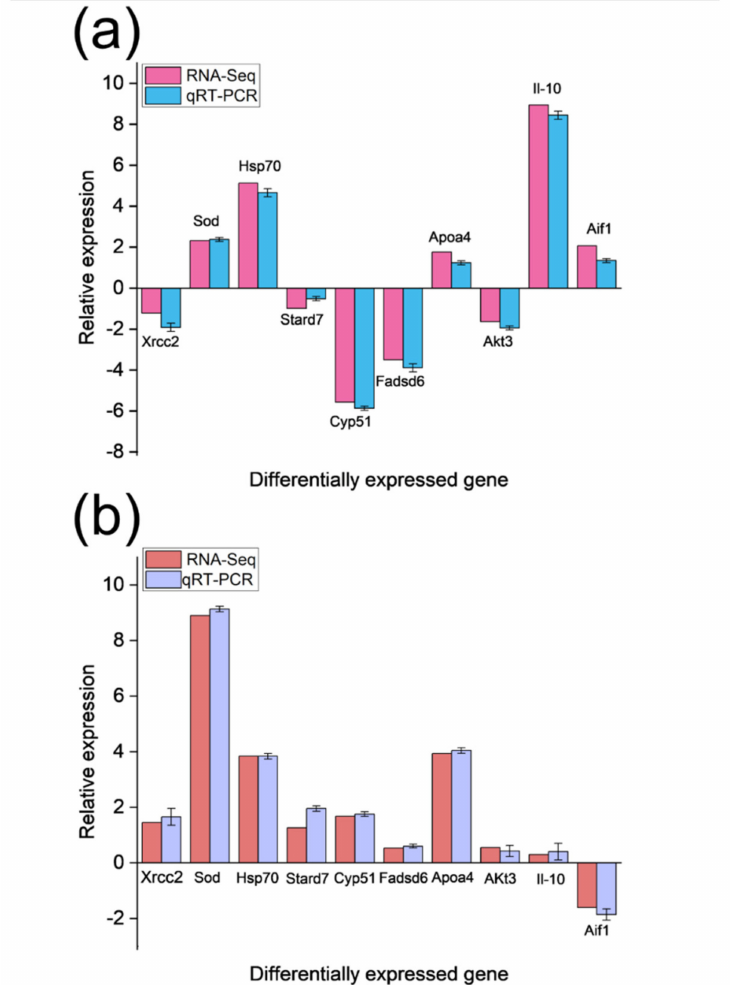
Figure 5. Comparative analysis of RT-qPCR and RNA-Seq results in HM-group ( a ) and MP-group ( b